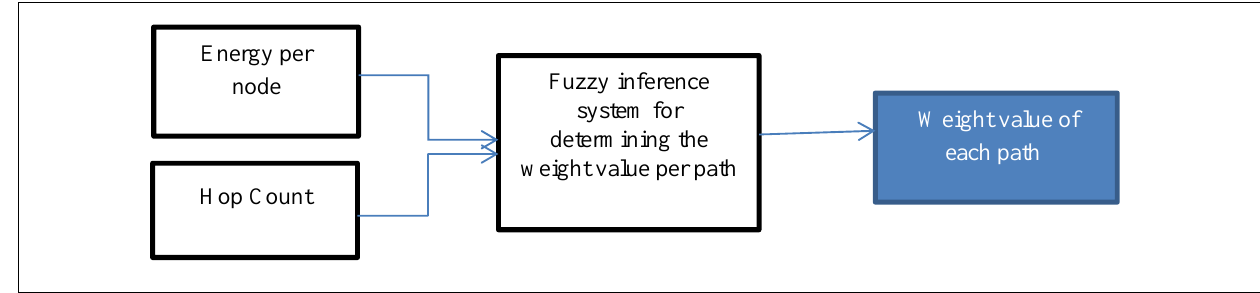
Fig. 3. The abstract view of fuzzy inference system for determining the weight value of each path The output of fuzzy system in the proposed WLL algorithm represents the weight of path. The more the WLL is reduced, the more its energy is enhanced and has higher priority in routing